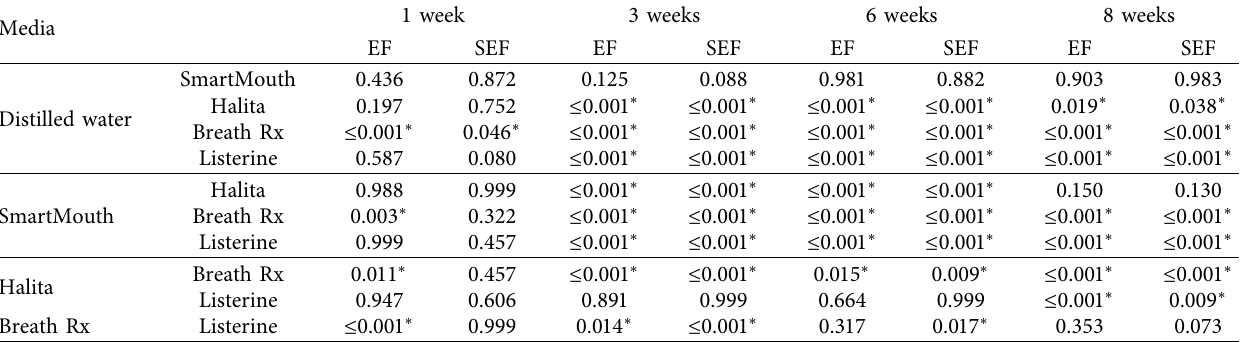
Table 7: Tukey’s HSD test for comparison between each two